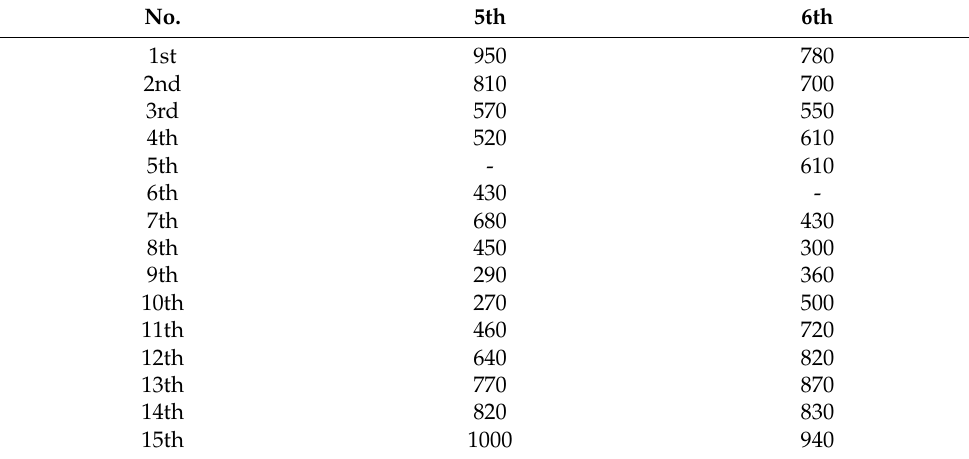
Table 4. Standard distance for wind turbine numbers 5 and 6 (meters).